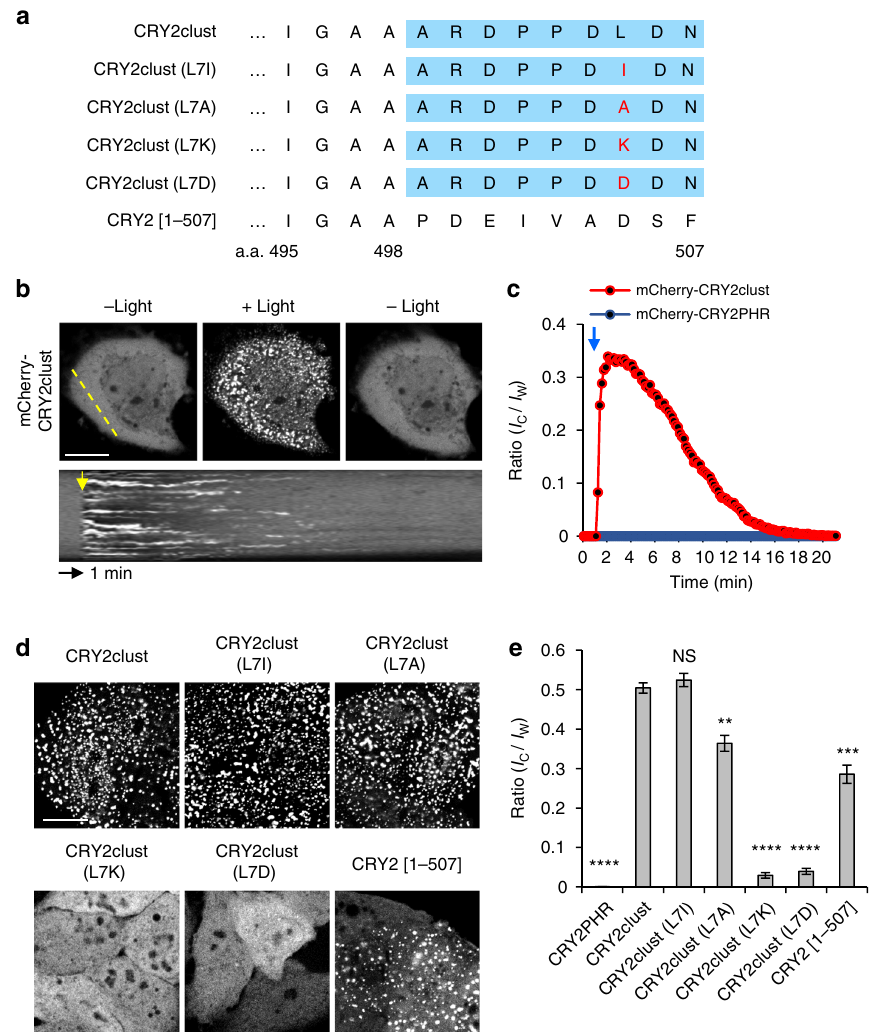
Fig. 2 Enhancement of light-induced CRY2 clustering by a C-terminal extension. a Sequences of CRY2 variants extended at the C-terminus of CRY2PHR [a.a. 1 – 498] with the nine residues of a new peptide ( blue box ) or those of native CRY2 [a.a. 1 – 507]. Mutated residues are shown in red . b Fluorescence images of a cell showing reversible clustering of mCherry-CRY2clust. Bottom , kymograph corresponding to the yellow line in the top left image. c Graph of time-lapse results showing changes in cluster ratio. Both yellow and blue arrows in b , c indicate illumination time points. d Fluorescence images of cells expressing each of the indicated mCherry-labeled CRY2 variants, upon light stimulation. Cells were illuminated with light for 5 min at 20 s intervals. e Quanti fi cation of cluster ratio. Values are expressed as means ± s.e.m. ( n = 72, 99, 91, 76, 98, 88, 97 cells, three independent experiments). ** P = 3.45 × 10 – 8 ; *** P = 5.57× 10 – 14 , **** P = 9.42 × 10 – 62 (CRY2PHR), 1.32 × 10 – 69 (CRY2clust(L7K)), 9.97 × 10 – 70 (CRY2clust(L7D)) by Student ’